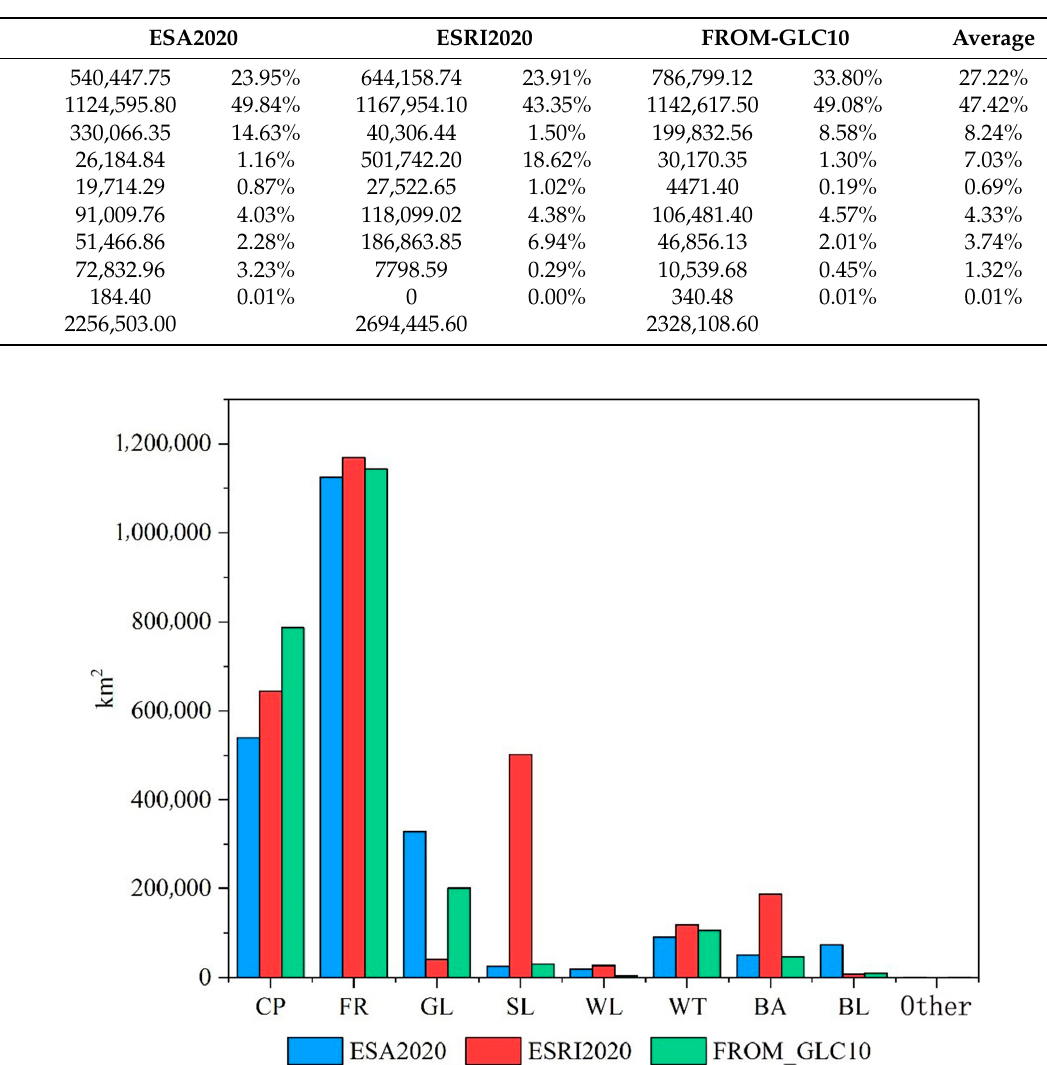
Table 6. The areas of the different land cover classes in the three products.